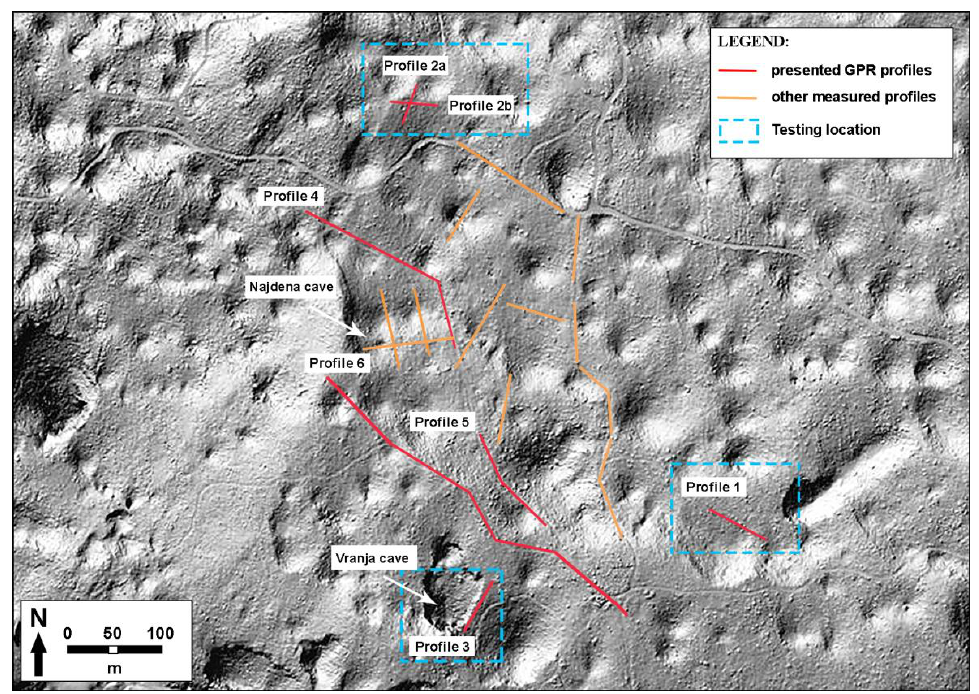
Figure 5. Locations of ground penetrating radar (GPR) profiles at the investigated area on the LiDAR shaded relief image. Testing locations (blue rectangles) were chosen where cave sediments and flowstone occur on the surface.